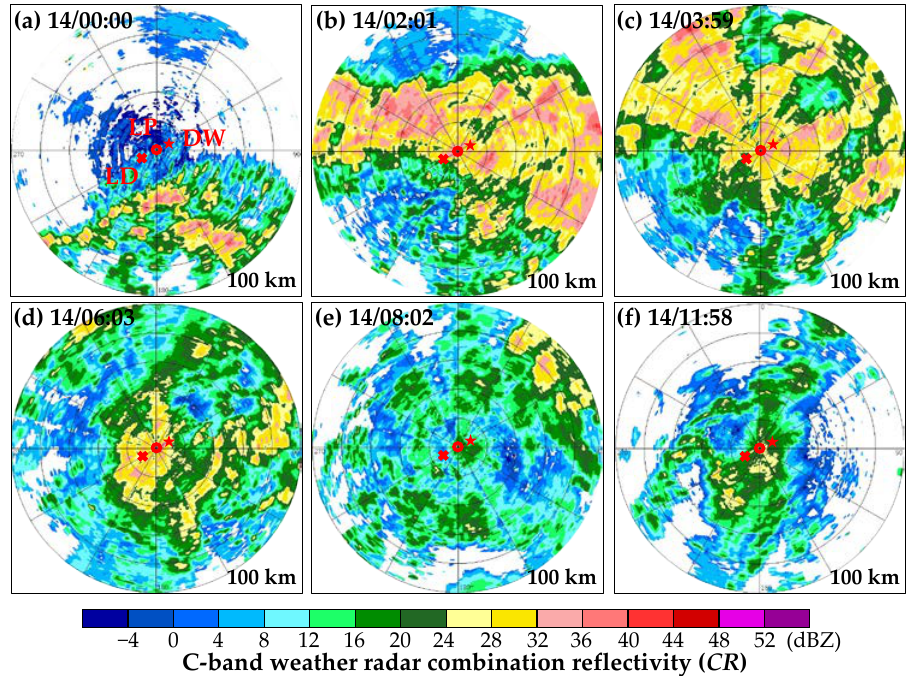
Figure 3. Combination reflectivity ( CR , dBZ) images from the C-band Doppler weather radar at the Guyuan station for the mixed cloud and precipitation process on 14 August 2020; ( a – f ) represent six different moments, and the cross, circle, and asterisk denote the locations of the LD, LP, and DW sites, respectively.